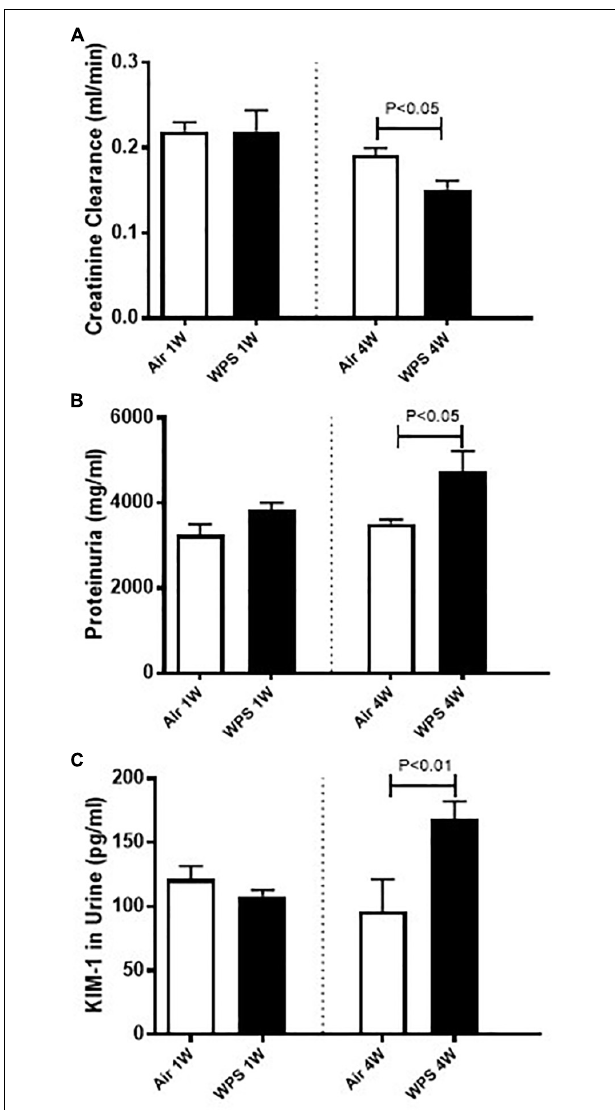
FIGURE 4 | Creatinine clearance (A) , and urinary concentrations of proteins (B) and kidney injury molecule-1 (KIM-1) (C) in mice at the end of the 1-week and 4-week exposure periods to air (control) or water-pipe smoke (WPS). Data are mean ± SEM ( n = 5–6).